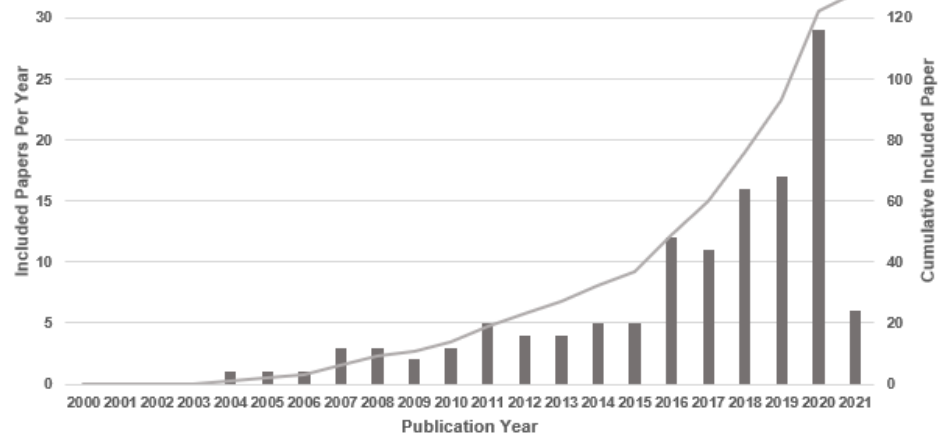
Figure 3. Temporal distribution of articles selected for